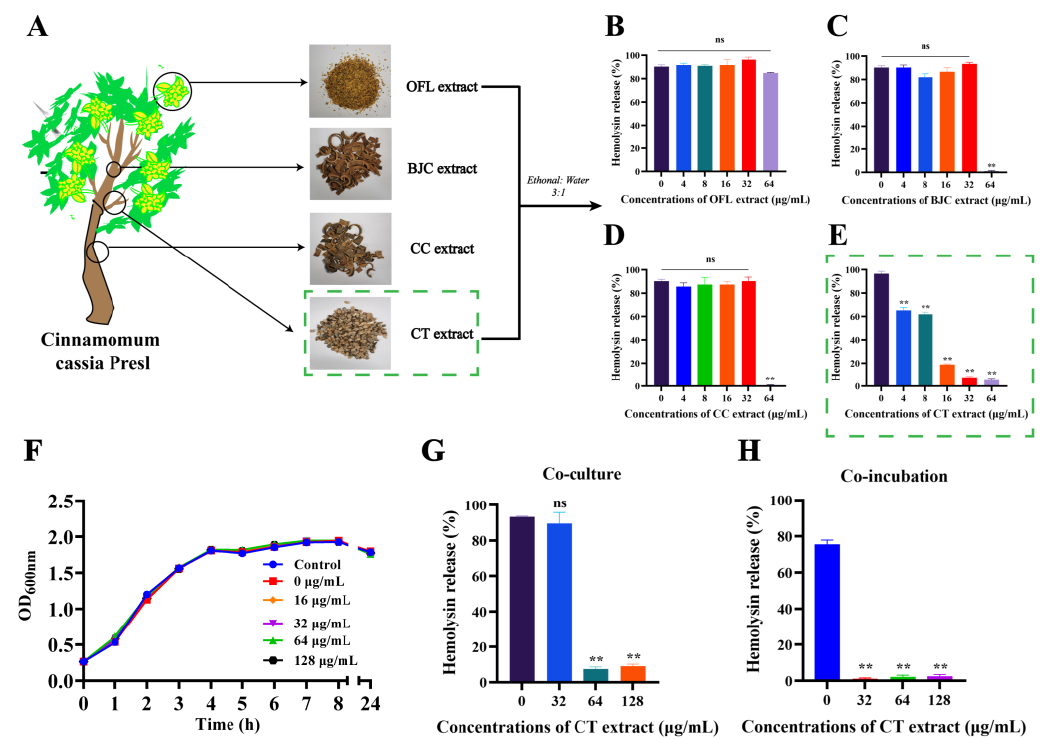
Figure 1. The effect of active components of Cinnamomum cassia on LLO activity. ( A ) The four extractions (OFL extract, BJC extract, CC extract and CT extract) from different parts of Cortex Cinnamomi . The hemolysis of purified LLO pre-treated with the indicated concentrations of OFL extract ( B ), BJC extract ( C ), CC extract ( D ) or CT extract ( E ) was determined using a hemolysis assay. ( F ) Growth curve of L. monocytogenes co-cultured with different concentrations of CT extract. ( G ) Hemolysis of the culture supernatants from L. monocytogenes co-cultured with CT extract. ( H ) Inhibition of hemolysis of L. monocytogenes supernatants pre-treated with the indicated concentrations of CT extract. The samples for hemolysis assay treated with PBS were regarded as a negative control and those treated with 0.2% Triton-X 100 were regarded as a positive control (100% hemolysis). ** p < 0.01 compared to the samples without extraction treatment. ns, not significant.